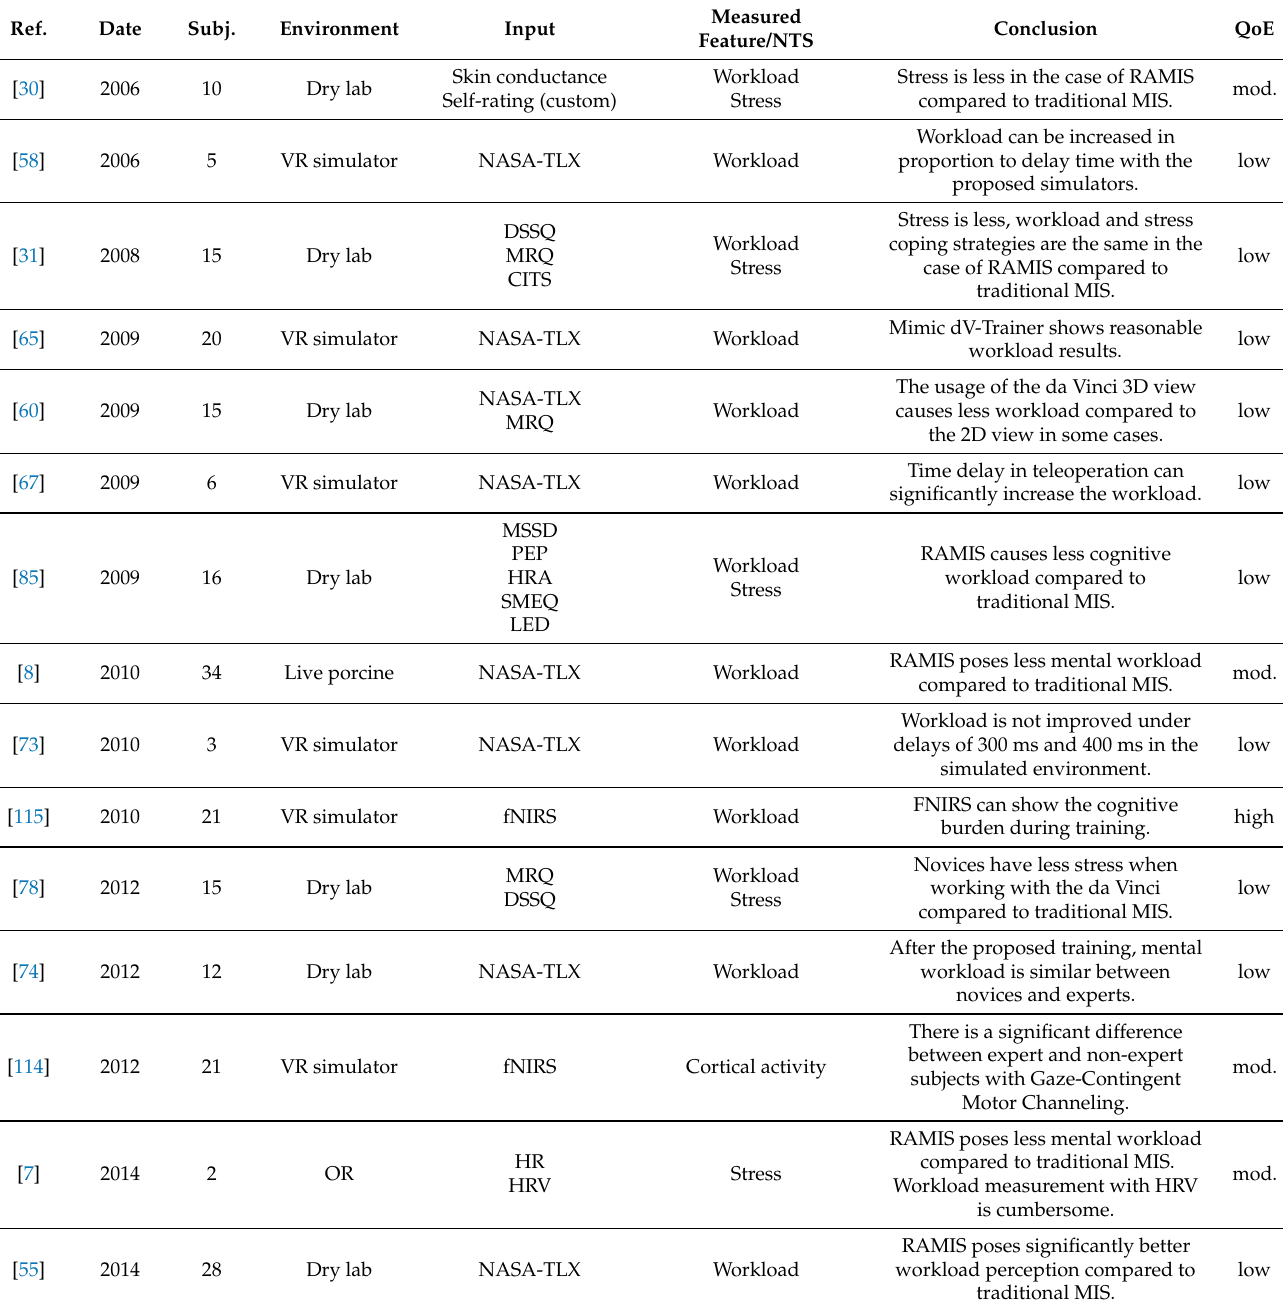
Table 5. Non-technical skill and mental workload assessment in surgical robotics. Used abbreviations: RAMIS: Robot- Assisted Minimally Invasive Surgery, OR: Operating Room, VR: Virtual Reality, EEG: electroencephalogram, NASA-TLX: NASA Task Load Index, SURG-TLX: Surgery Task Load Index, NOTSS: Non-Technical Skills for Surgeons, MRQ: Multiple Resources Questionnaire, DSSQ: Dundee Stress State Questionnaire, ECG: electrocardiogram, HR: heart rate, HRV: heart rate variability, RSME: Rating Scale for Mental Effort, PTICSQ: Psychometric Testing of Interpersonal Communication Skills Questionnaire, SAQ: Safety Attitudes Questionnaire, fNIRS: Functional Near-Infrared Spectroscopy, PVT: Psychomotor Vigilance Test, WCST: Wisconsin Card Sorting Test, CITS: Coping Inventory of Task Stress, MSSD: mean square of successive differences between consecutive heartbeats, PEP: time of isovolumetric contraction, HRA: average heart rate, SMEQ: Subjective Mental Effort Questionnaire, LED: Local Experienced Discomfort, SSSQ: Short Stress State Questionnaire, p.: procedures (where no subject data were available), QoE: Quality of Evidence, mod.: moderate.